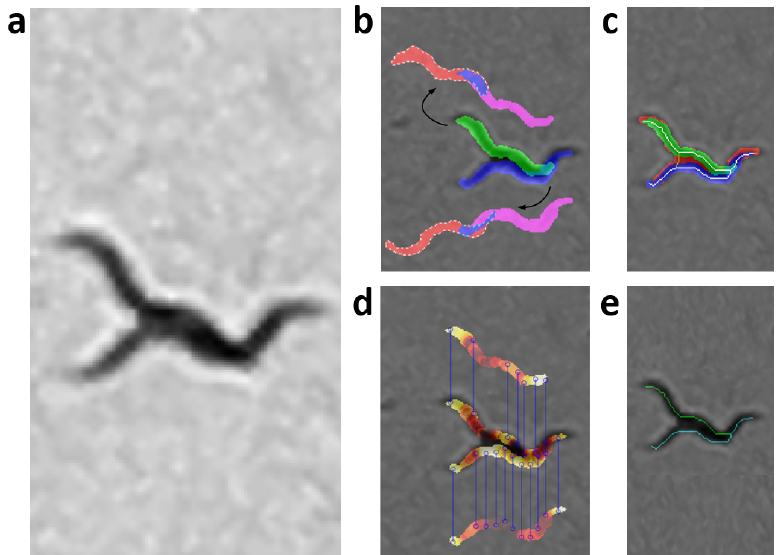
Figure 11. Model 7 evaluation. The yellow and white pixels are the resulting skeleton using the improved form of skeletonizing. The white pixels are the pixels of the skeleton prediction, which are used to reconstruct the body of each worm (segmentation in blue and green). ( a ) Grayscale image. ( b ) Overlap criterion evaluation. ( c ) Completeness criterion evaluation. ( d ) Color criterion evaluation. ( e ) Optimization result.